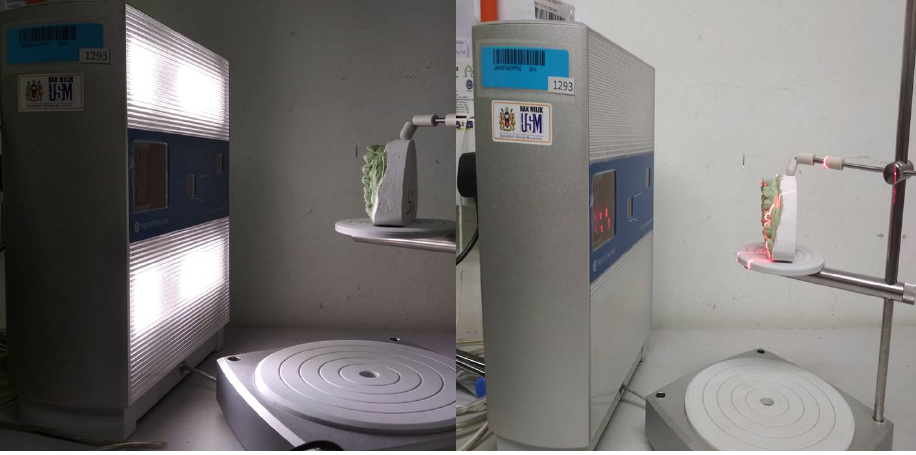
Figure 1. Dental cast scanning using the Next Engine 3D